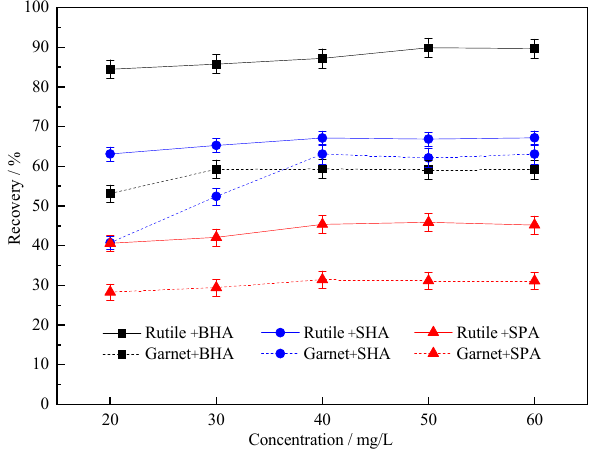
Figure 4. Effect of concentration on the flotation of rutile and garnet. (pH = 7 with BHA, pH = 9 with SHA, pH = 8 with SPA).